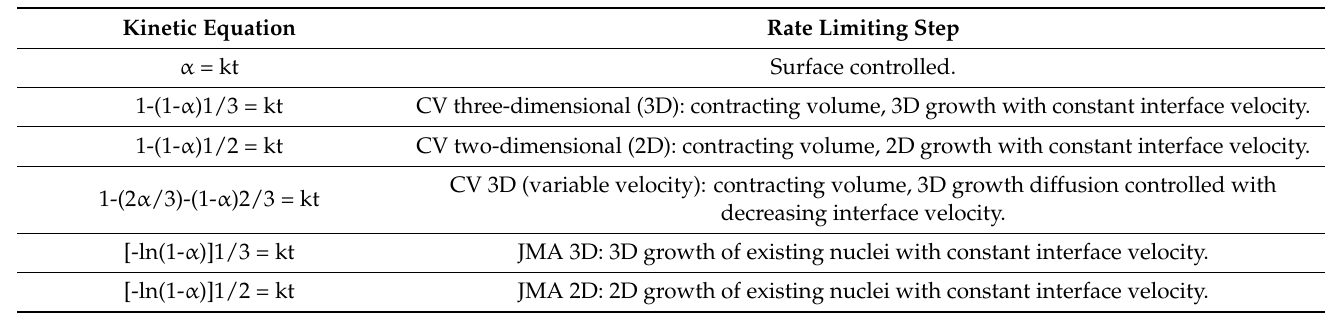
Table 2. Kinetic model used for sorption kinetics of current study, where α, t , and k refer to reacted fraction, time, and reaction rate constant, respectively. Based on [62].